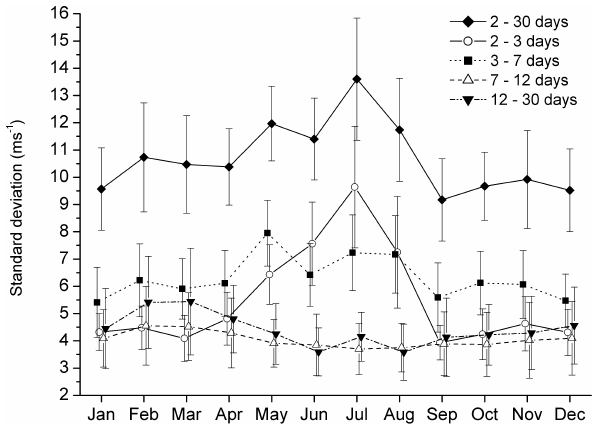
Fig. 3. 1980–2005 mean monthly mean standard deviations σ h of daily winds at different period bands.